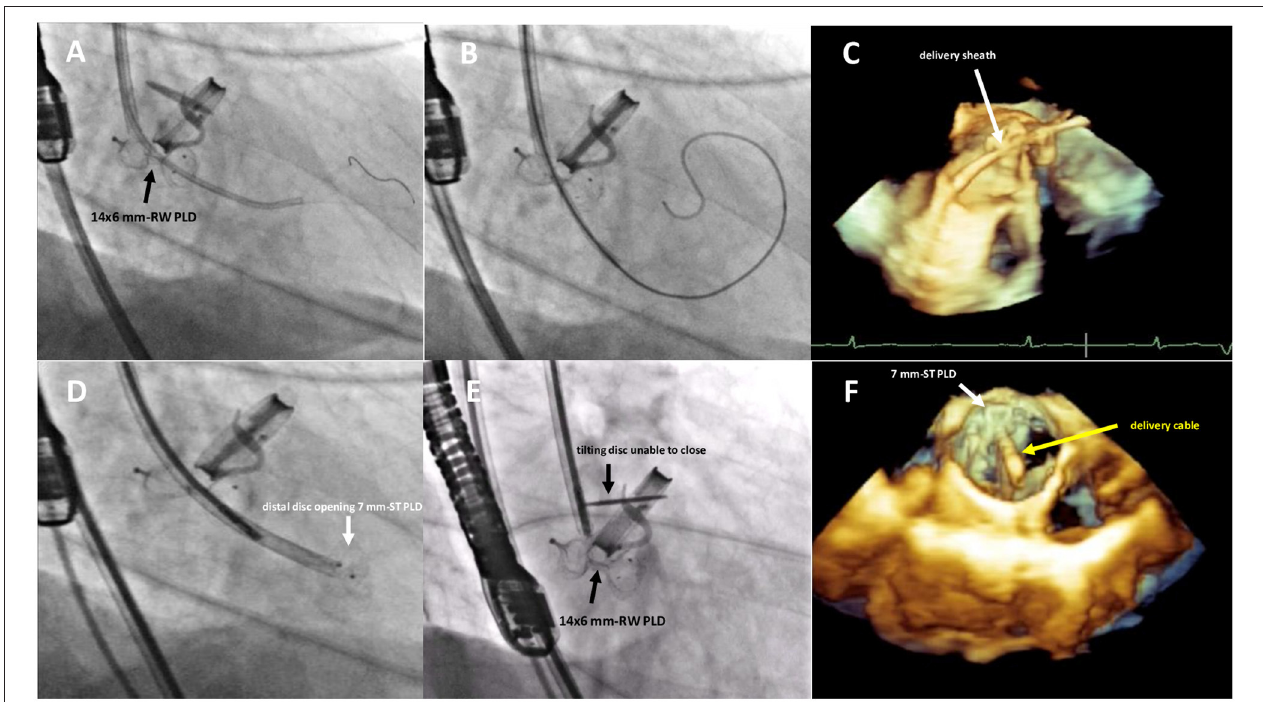
FIGURE 3 | Fluoro-angiographic and real-time 3D TEE procedural steps showing the crossing of the residual leakage in close proximity of the already implanted 14 × 6mm rectangular waist PLD (A–C) , the distal disc opening of the 7mm square twist PLD (D) still anchored to the delivery cable and the inference with the tilting disc of the mechanical aortic valve (E,F) . RW, rectangular waist; ST, square twist.